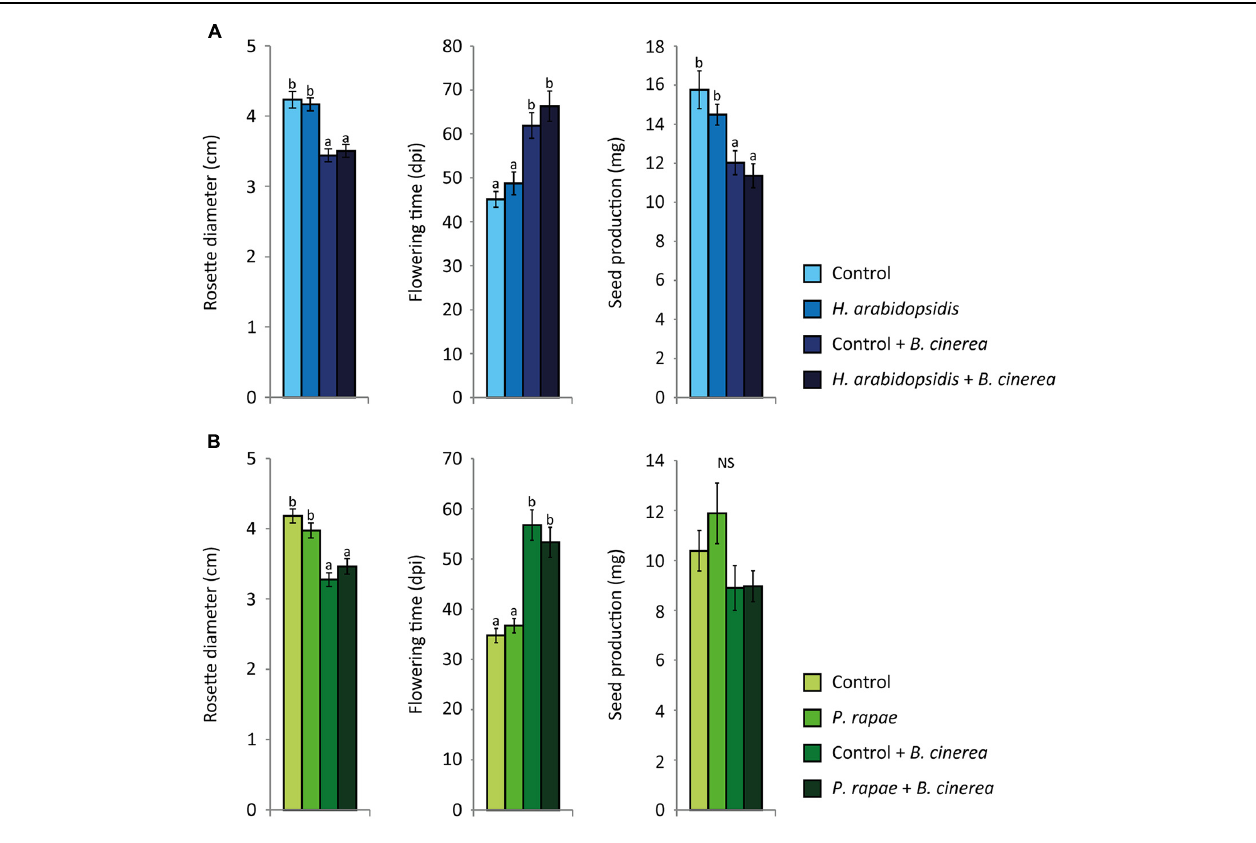
caterpillars (B) . At 24 h the caterpillars were removed after which all plants were inoculated with B. cinerea (A,B) . Different letters indicate a statistically significant